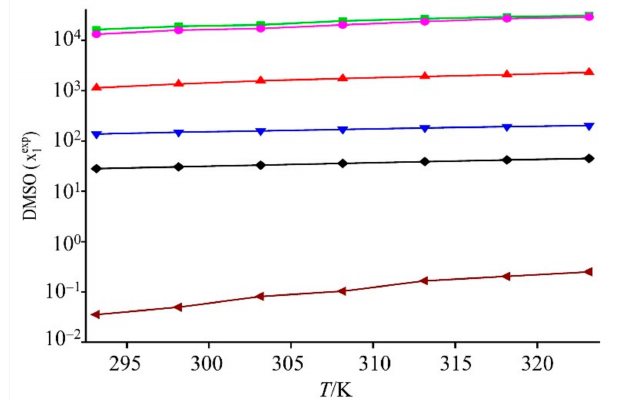
Figure 2. Experimental mole fraction solubility ( X exp ) of GLN in various organic solvents at T = (293.15~323.15) K: mole fraction solubility in DMSO (in green), NMP (in pink), 1,4-dioxane (in red), PEG 400 (in blue), THP (in black), and water (in maroon) are from static equilibrium